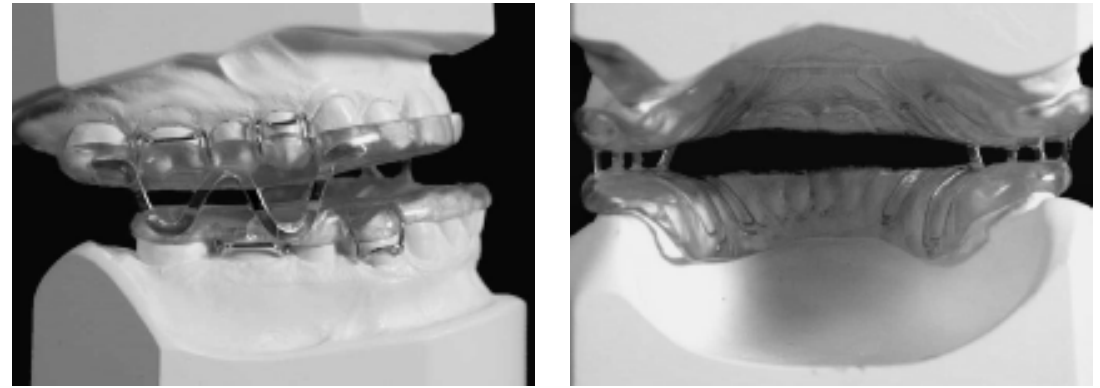
Monobloc mandi- bular advancement device as used at the University Hospital of Zurich. The cus- tom-fitted appliance is snapped onto the dental arches for overnight treatment and held in place by metallic clasps. The protrusive forces acting onto the mandible are distrib- uted over a large area of the alveolar process (modified from